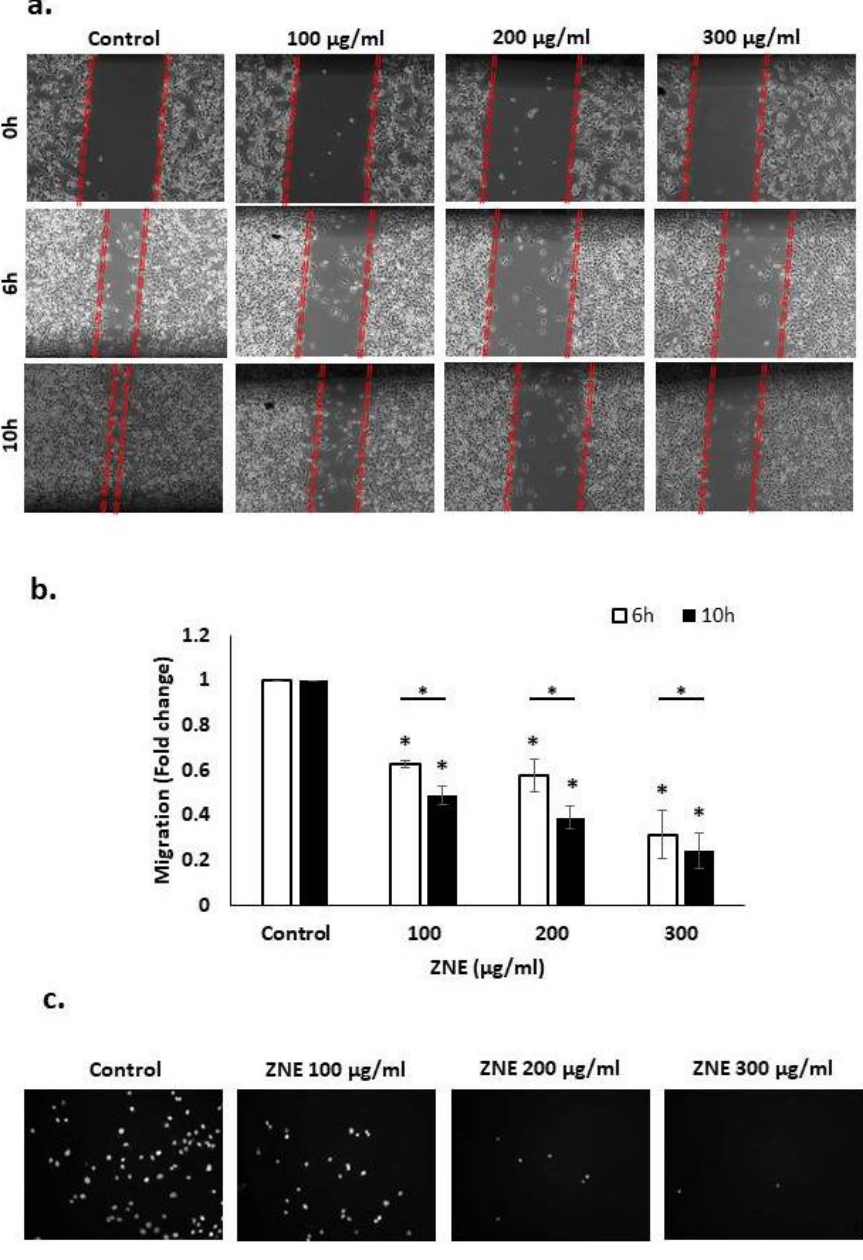
Figure 4. Ziziphus nummularia inhibits the migration of Capan-2 cancer cells. ( a ) Confluent cultures of Capan-2 cells were wounded by scratching with a pipette tip, and the cells were incubated without and with the indicated concentrations of ZNE. Representative photomicrographs of the wound were taken at the indicated timepoints. ( b ) Values are plotted as fold change of the vehicle-treated (control) cells. Data represent the average of three replicates. Two-way ANOVA shows that the ZNE-repressed migration is statistically significant in a concentration and time-dependent fashion. ( c ) Capan-2 cells were incubated for 24 h with or without the indicated ZNE concentrations in Boyden chamber transwell inserts as described in Materials and Methods. Migrating Capan-2 cells were stained with Nucblue ® and photographed at × 10 magnification. (* denotes a p <